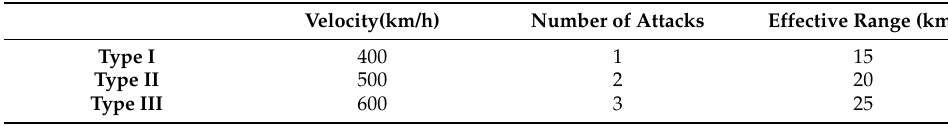
Table 3. Capabilities of the three types of